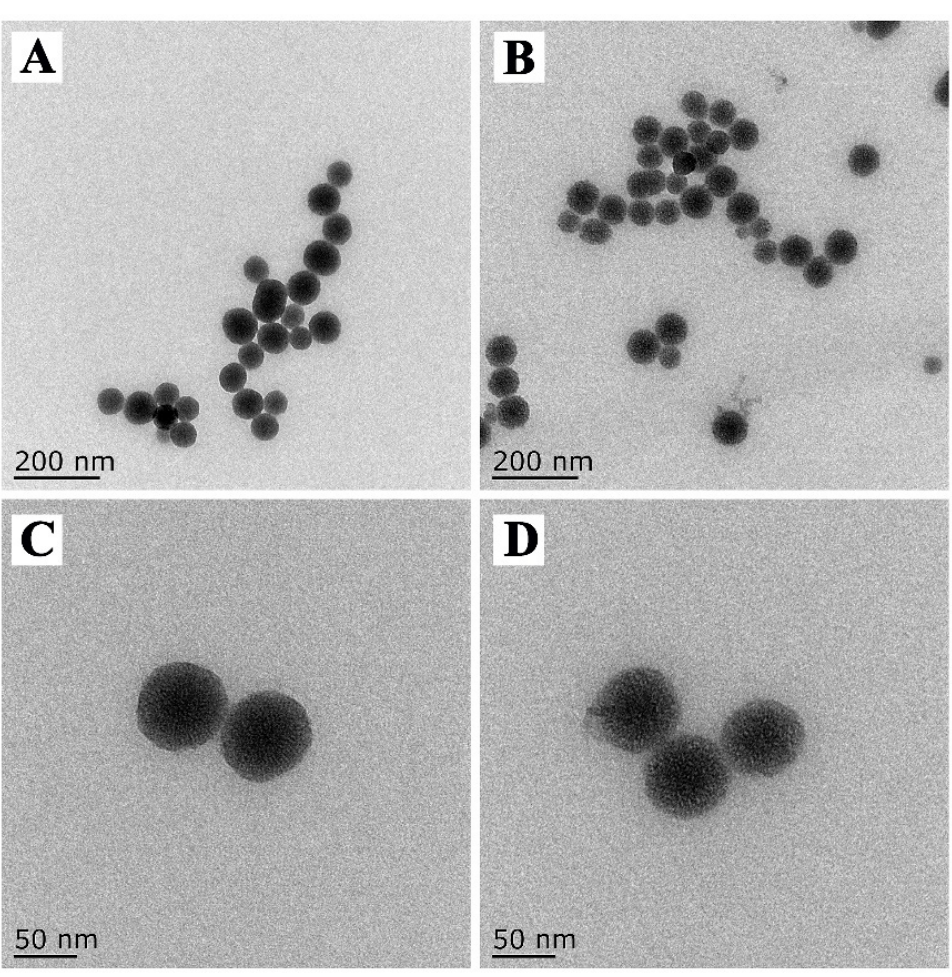
Figure 3. TEM images of DMON nanoparticles ( A , C ) and PRO@DMON–GA–Fe(III) nanoparticles ( B , D ). To further verify the formation processes of PRO@DMON–GA–Fe(III) nanoparticles, absorption peaks at 1084, 803, and 464 cm − 1 , respectively (Figure 4D). These peaks can